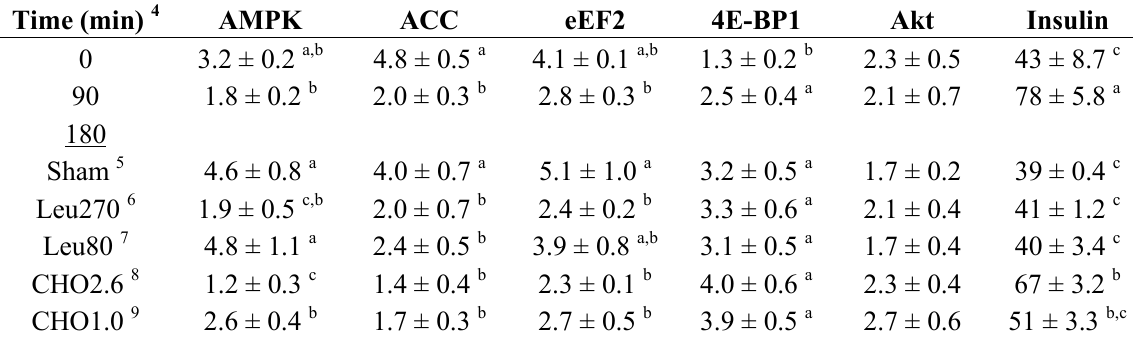
Table 2. Post-meal signaling 1 and plasma insulin 2 results for Experiment 1 3